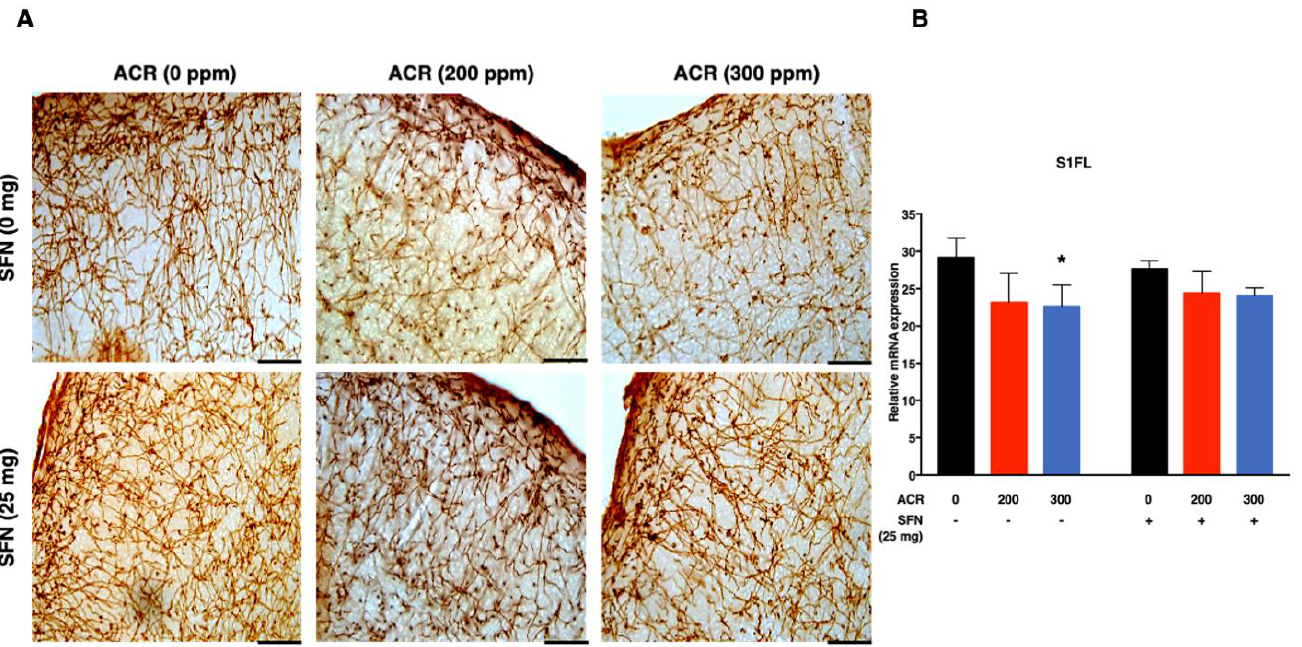
Figure 4. Representative photomicrographs ( A ) and density ( B ) of noradrenaline transporter (NAT)-immunoreactive axons in the forelimb primary somatosensory cortex (S1FL) of mice following exposure to acrylamide and treatment with sulforaphane. Data are mean ± SD. * p < 0.05, compared to the corresponding control (by ANOVA followed by Dunnett’s multiple comparison). Scale bars = 40 µm; n = 4.